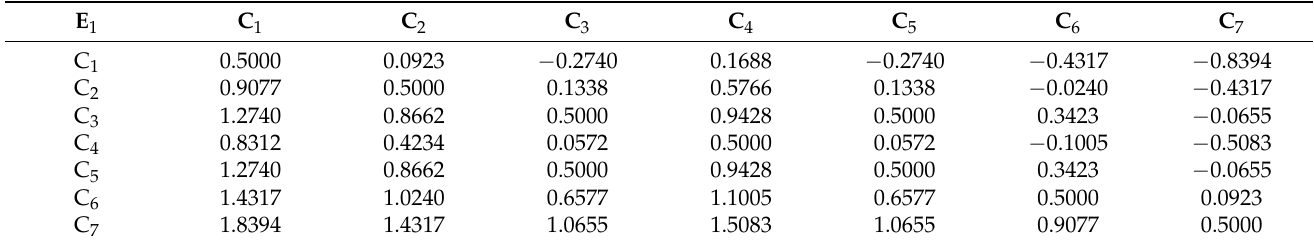
Table 7. Consistent fuzzy preference relation matrix of criteria evaluated by E1 in